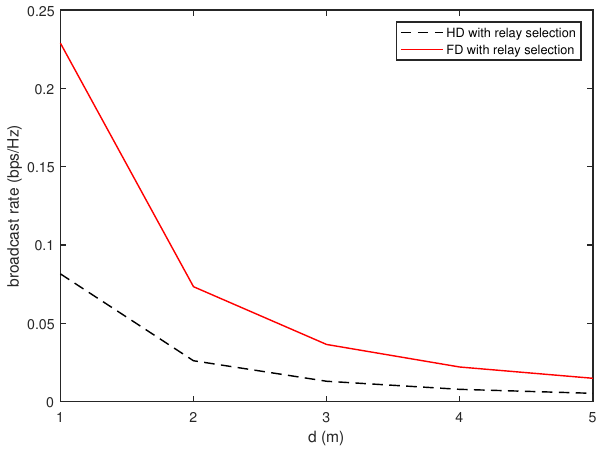
Figure 2. Comparison of broadcast rates as a function of d ( ¯ P = 10).